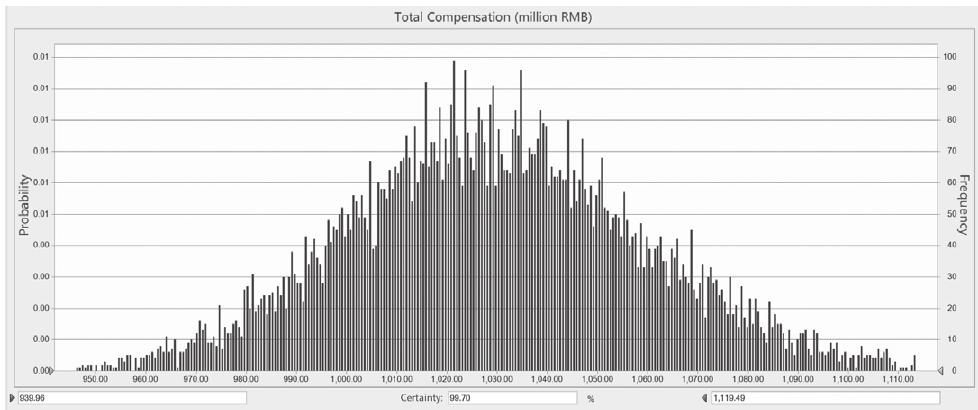
Figure 4. Probability distribution of total compensation